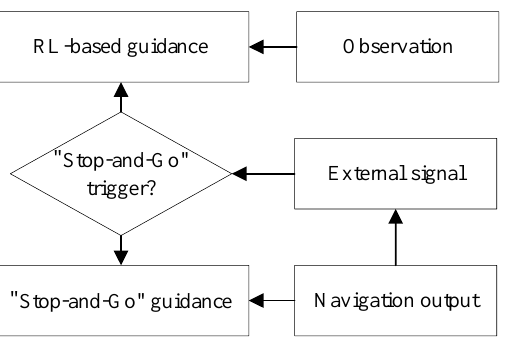
Figure 8. DRL-based guidance combined with SaG strategy: determine whether to insert SaG point at a certain time or at a certain point of the original trajectory according to the external trigger signal.